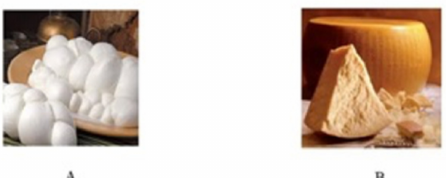
Figure 1. ( A ) “Braided” fresh mozzarella from bu ff alo cheese, typically produced mainly in central-southern Italy but possibly appreciated all over the world. ( B ) Parmesan cheese shape and wedge: the most select parmesan cheese may have undergone up to 36 months of aging in controlled atmosphere. The standard weight of a matured parmesan shape is about 40 kg, for which about 550 lt of cow milk is